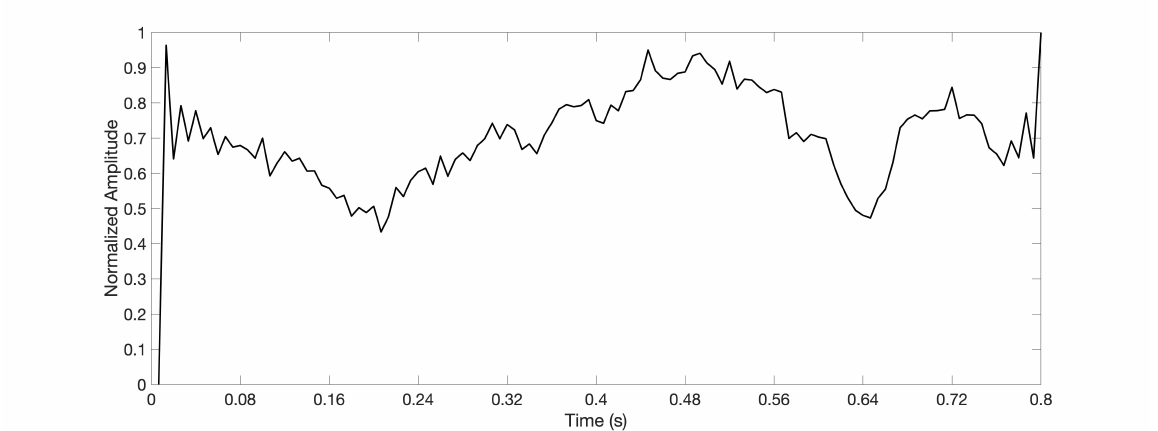
Figure 7. Averaged Target ERP.